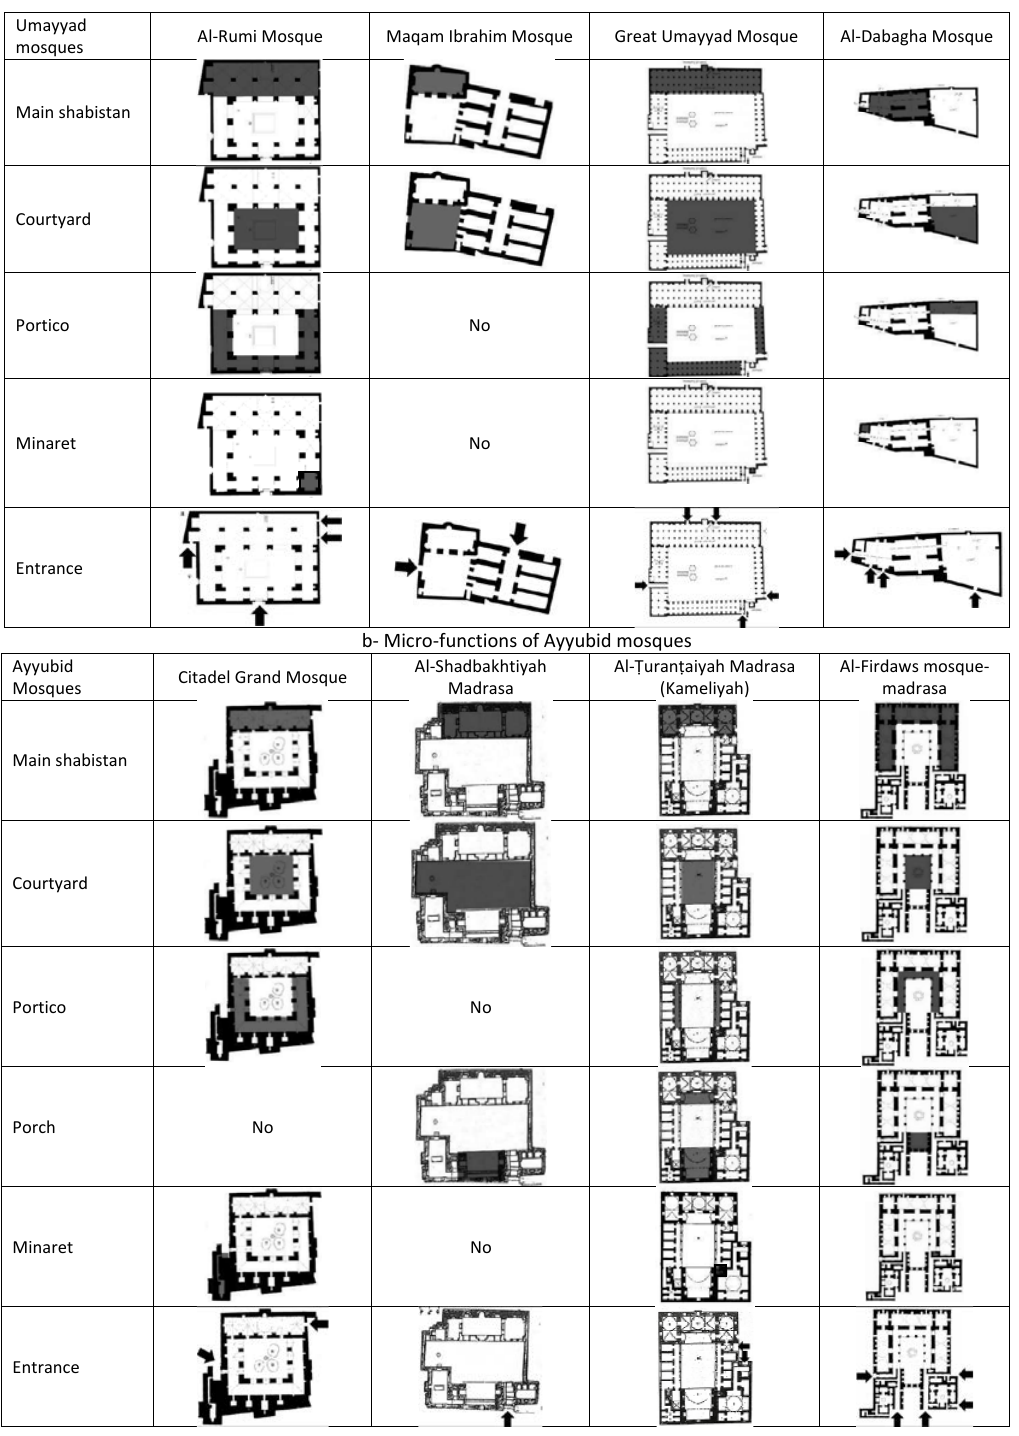
Table 2: Micro-functions of historical mosques a- Micro-functions of Uumayyad Table 2: Micro‐functions of historical mosques a‐ Micro‐functions of Uumayyad mosques